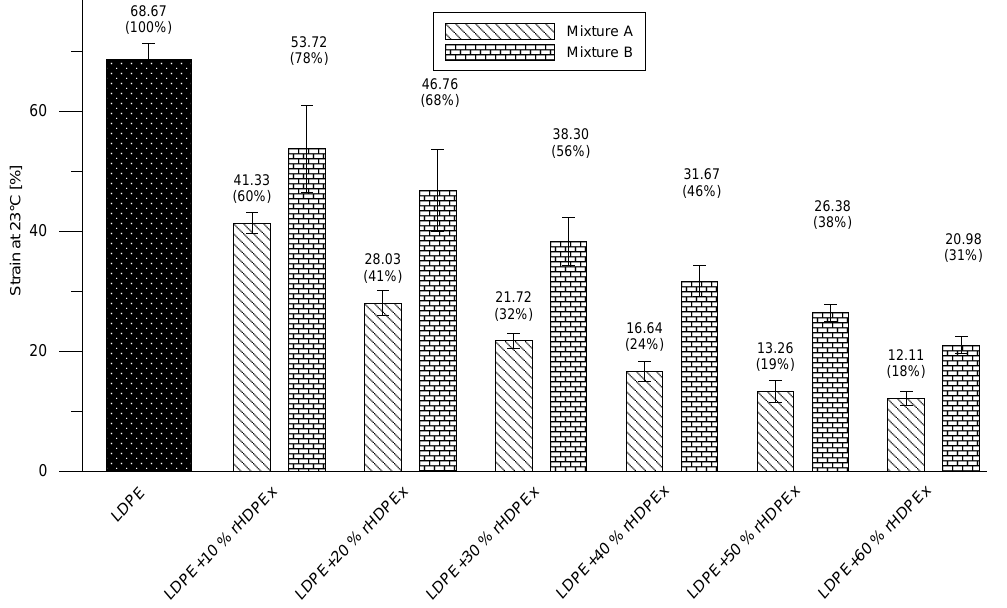
Figure 8. Strain at ambient temperature—Mixtures A and